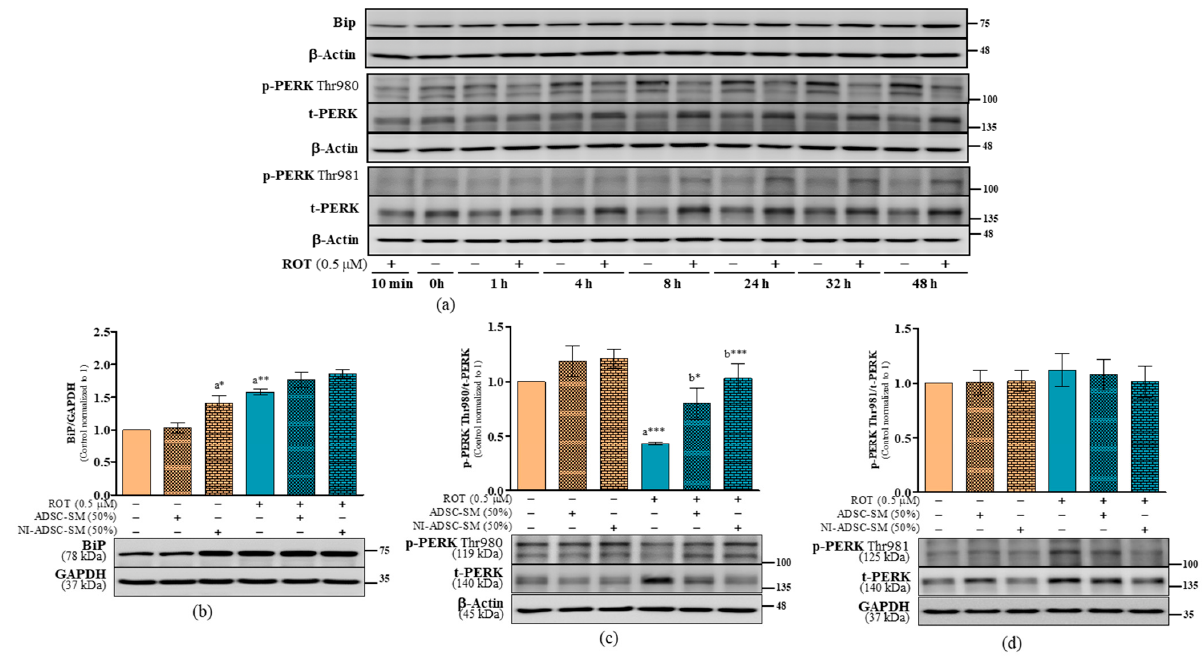
Figure 8. Effects of the NI-ADSC-SM on BiP and PERK expression. Cells treated with or without ROT (0.5 μ M) at different timepoints were assessed for BiP and PERK by Western blotting ( a ). Cells were incubated in the presence of ROT (0.5 μ M) or DMSO for 48 h alone or with the ADSC-SM or NI-ADSC-SM (each diluted by 50%) during the last 24 h. The levels of BiP/GAPDH ( b ), p-PERK Thr980/t-PERK ( c ), and p-PERK Thr981/t-PERK ( d ) protein expression were assessed by Western blotting. Data are shown as the means (bars) and SEM (error bars) of three independent cell culture experiments. Statistical analysis was performed using one-way ANOVA with Tukey’s post-test. Statistical comparisons: a—compared with control; b—compared with ROT; * p < 0.05, ** p < 0.01, and *** p < 0.001. p-, phosphorylated; t-, total.